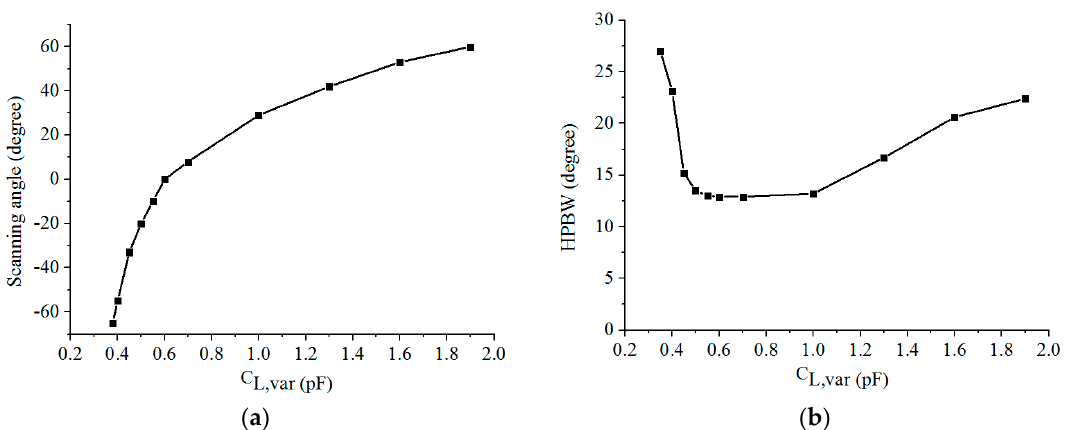
Figure 8. Scanning angle and half-power beamwidth (HPBW) of the LWA versus C L,var . ( a ) Scanning angle; ( b ) HPBW.